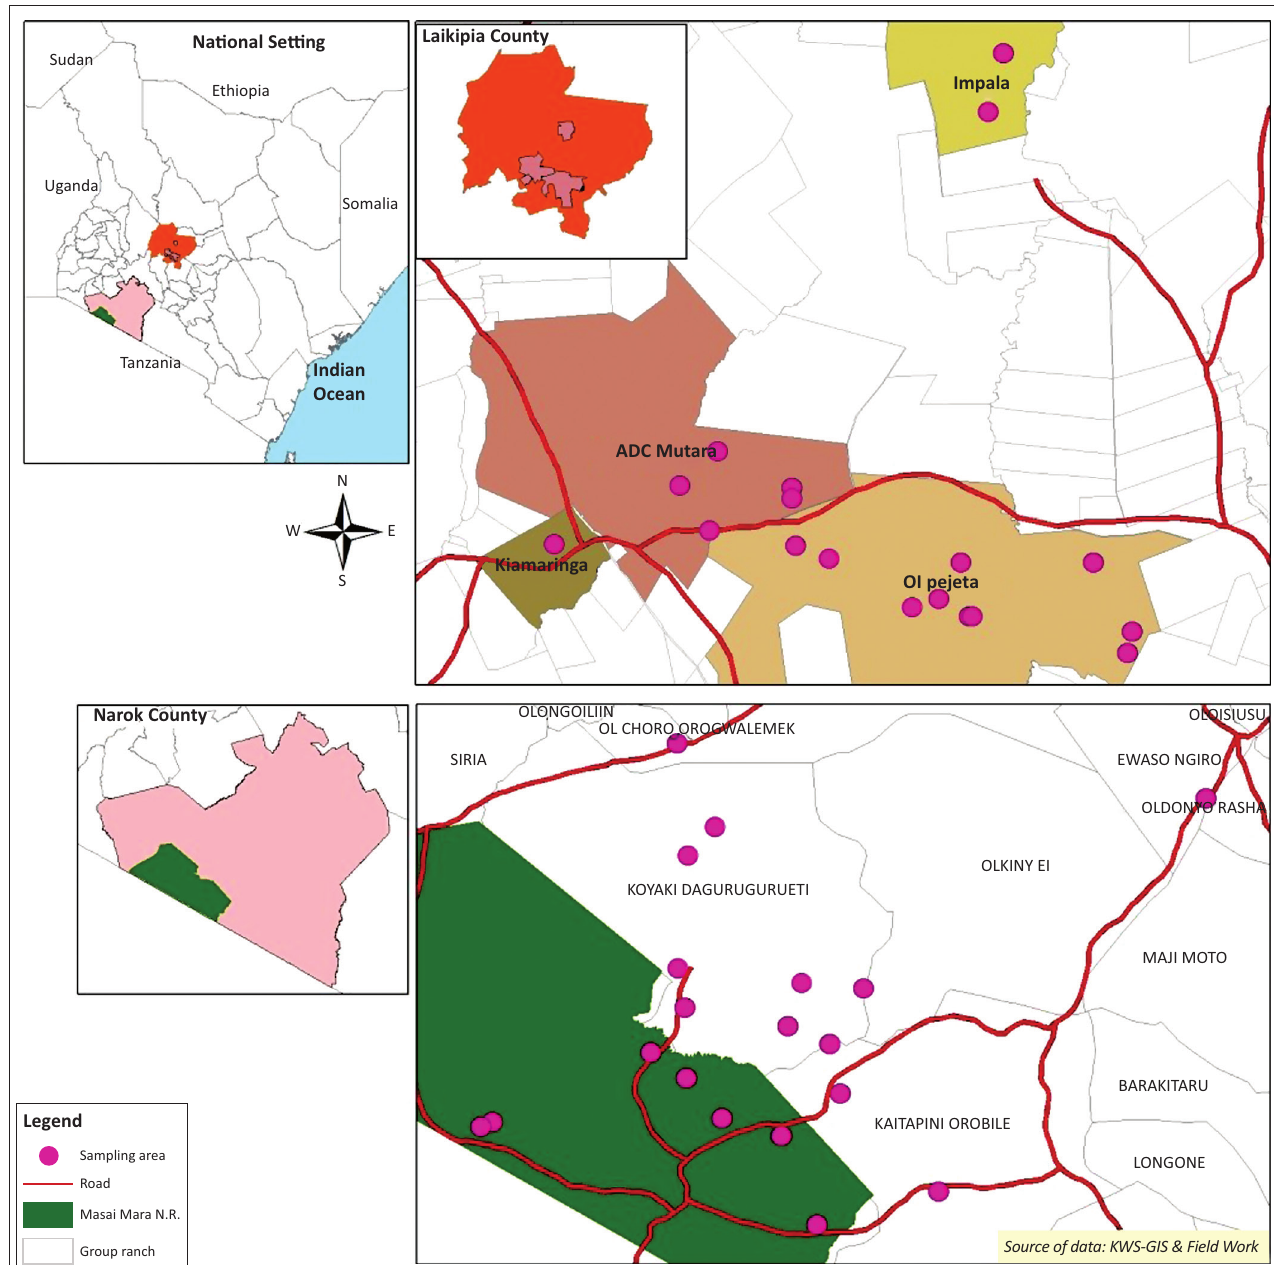
FIGURE 1: Sampled sites in Laikipia and Maasai